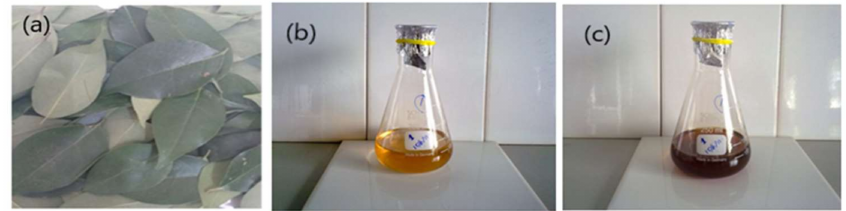
Figure 1. ( a ) L. Lucidum plant leaves; ( b ) Leaf extract and aqueous solution of AgNO 3 ; ( c ) synthesis of silver